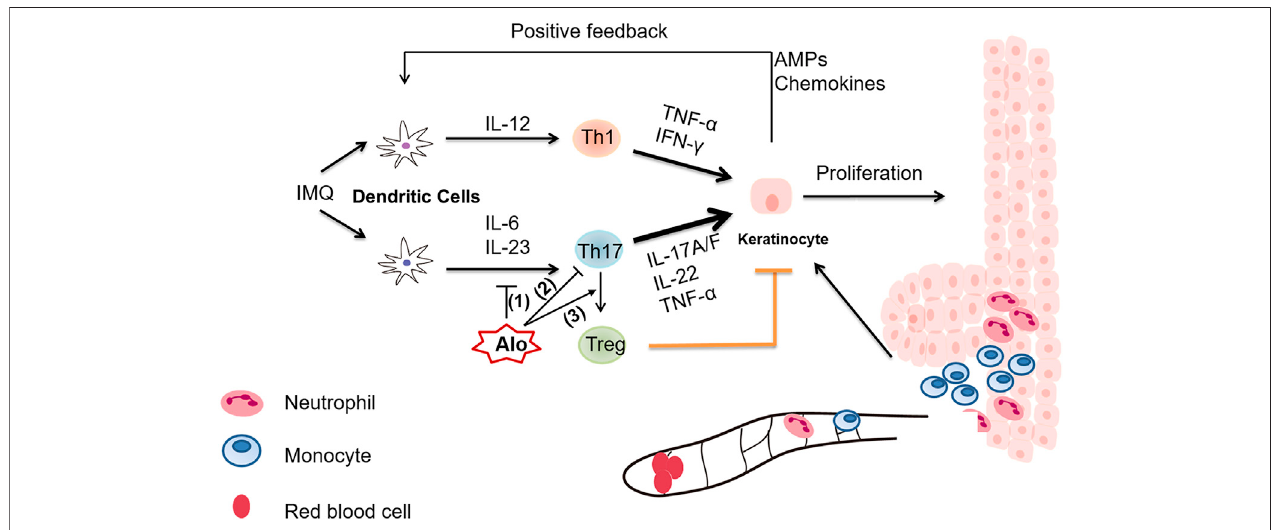
FIGURE 7 | A graphical illustration of aloperine-mediated suppression of the Th17 program in the mouse psoriasis model. (1) Aloperine inhibits the migration, activation,andTh17-inducingcapabilityofDCs.(2)AloperinedirectlyinhibitsTh17polarizationbysuppressingthephosphorylationofSTAT3.(3)Aloperinepromotesthe trans-differentiation of Th17 into